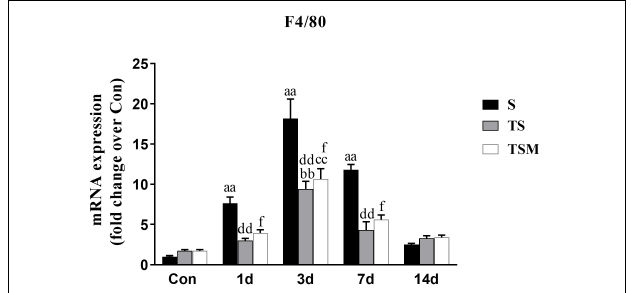
FIGURE 2 | Effects of clodronate-containing liposomes one marker of macrophage in injured skeletal muscle. S, muscle contusion group; TS, muscle contusion and macrophage depleted group; TSM, muscle contusion, macrophage depletion and MGF treated group. Data are means ± SEM, n = 8; a Significant difference from Scon, p < 0.05; aa p < 0.01. b Significant difference from TScon, p < 0.05; bb p < 0.01. c Significant difference from TSMcon, p < 0.05; cc p < 0.01; d Significant difference between group TS and group S, p < 0.05; dd p < 0.01; e Significant difference between group TS and group TSM, p < 0.05; ee p < 0.01; f Significant difference between group TSM and group S, p < 0.05; ff p < 0.01.